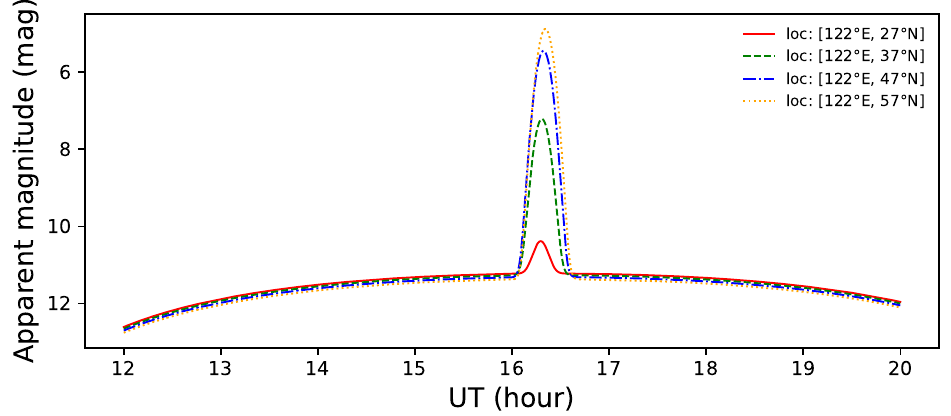
Figure 9. The synthetic light curves simulated with the same model parameters and different station